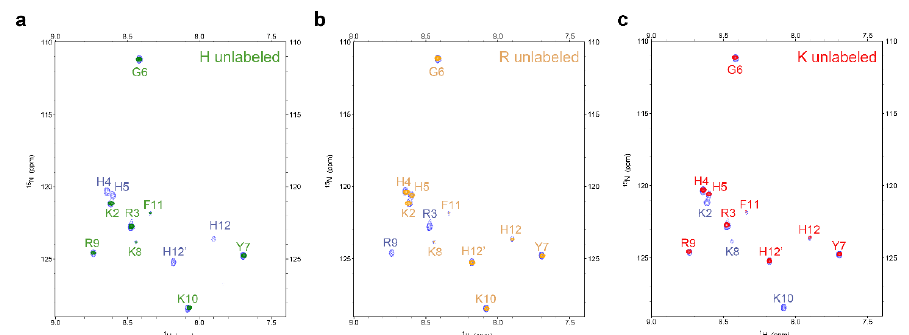
Figure 5. 1 H- 15 N HSQC spectra for the different selectively unlabeled samples of P-113 treated with C. albicans at 301 K for 24 h. Blue peaks represent for uniformly 15 N-labeled P-113: (a) green peaks for histidine selectively unlabeled P-113; (b) brown peaks for arginine selectively unlabeled P-113; (c) red peaks for lysine selectively unlabeled P-113.